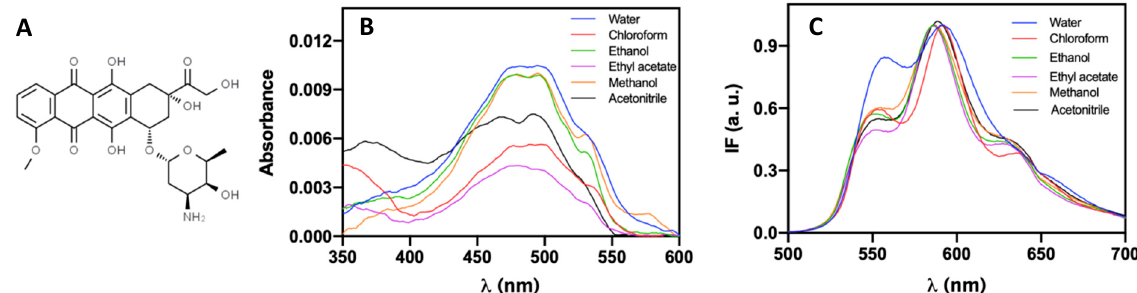
Figure 7. ( A ) Molecular structure of doxorubicin (C 27 H 29 NO 11 ); ( B ) Absorption spectra of doxorubicin solutions, at 1 × 10 − 5 M, in several solvents; ( C ) Normalized fluorescence (at peak of maximum emission) spectra of doxorubicin (1 × 10 − 6 M, λ exc = 480 nm) in several solvents. Table 2. Maximum absorption ( λ abs ) and emission wavelengths ( λ em ), molar absorption coefficients ( ε ) and fluorescence quantum yields ( Φ F ) for doxorubicin in several solvents.